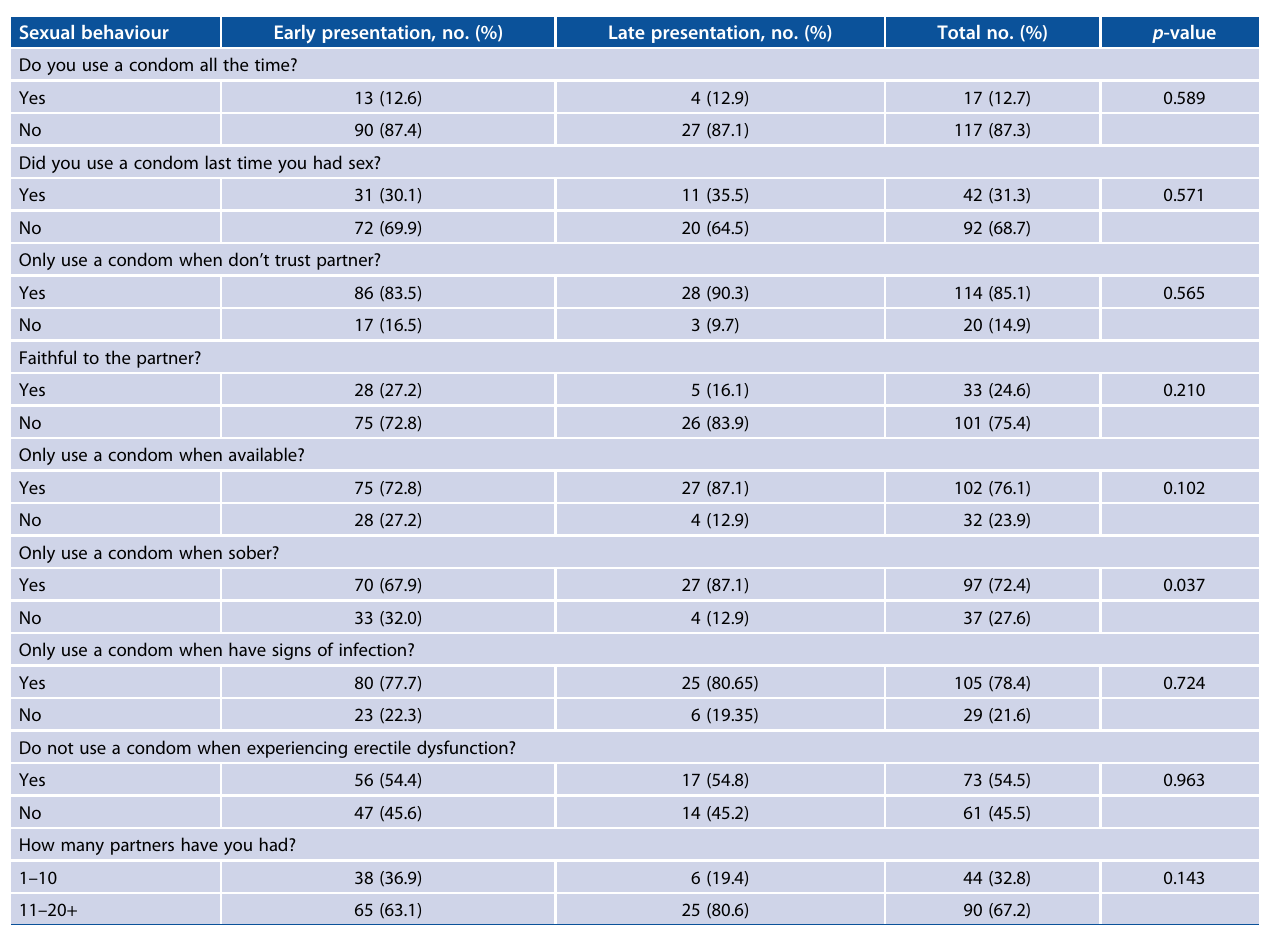
Table 2: Men ’ s self-reported sexual behaviour showing the proportions in the early presentation ( n = 103; 76.9%) vs. late presentation ( n = 31; 23.1%) groups (number, %) Sexual behaviour Early presentation, no. (%) Late presentation, no. (%) Total no.